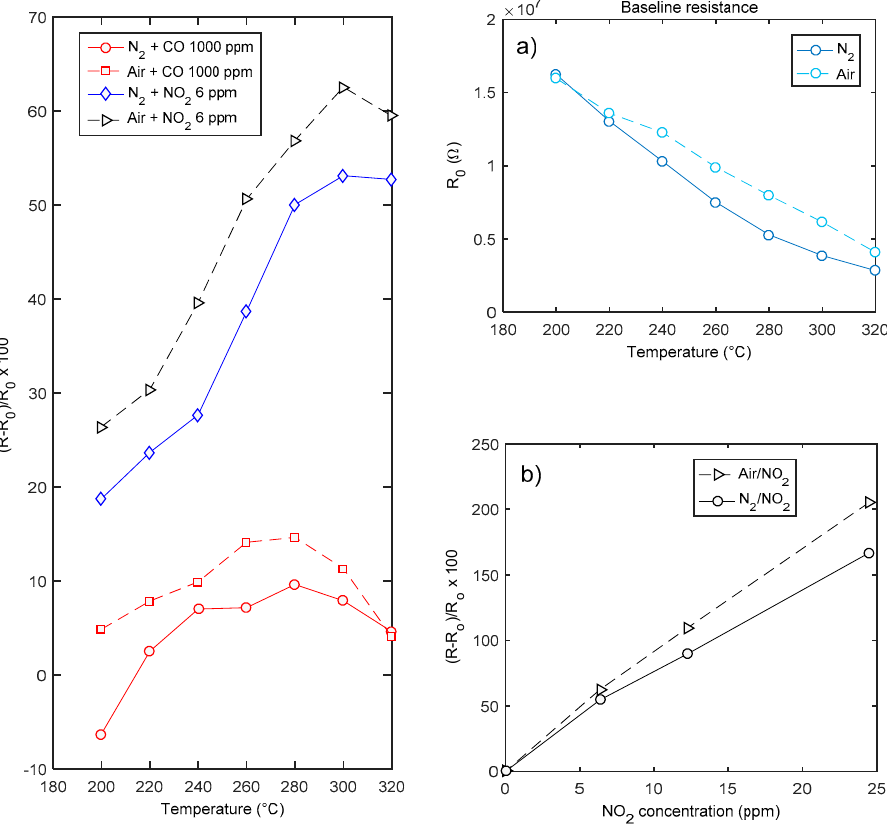
Figure 10. Gas sensing properties of a In 2 O 3 sensor (deposition time 4 h, named hereafter sensor A). Leftmost plot—response as a function of temperature to CO and NO 2 . Rightmost plots: ( a ) baseline resistance in air as a function of temperature; ( b ) response to NO 2 as a function of NO 2 concentration at 300 °C.